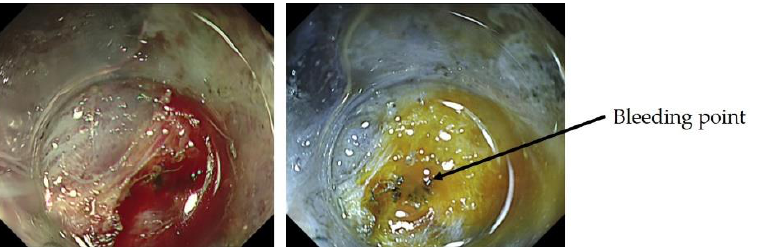
Figure 11. No glandular structures were observed, and wavy micro vessels were observed, suggesting undifferentiated adenocarcinoma.